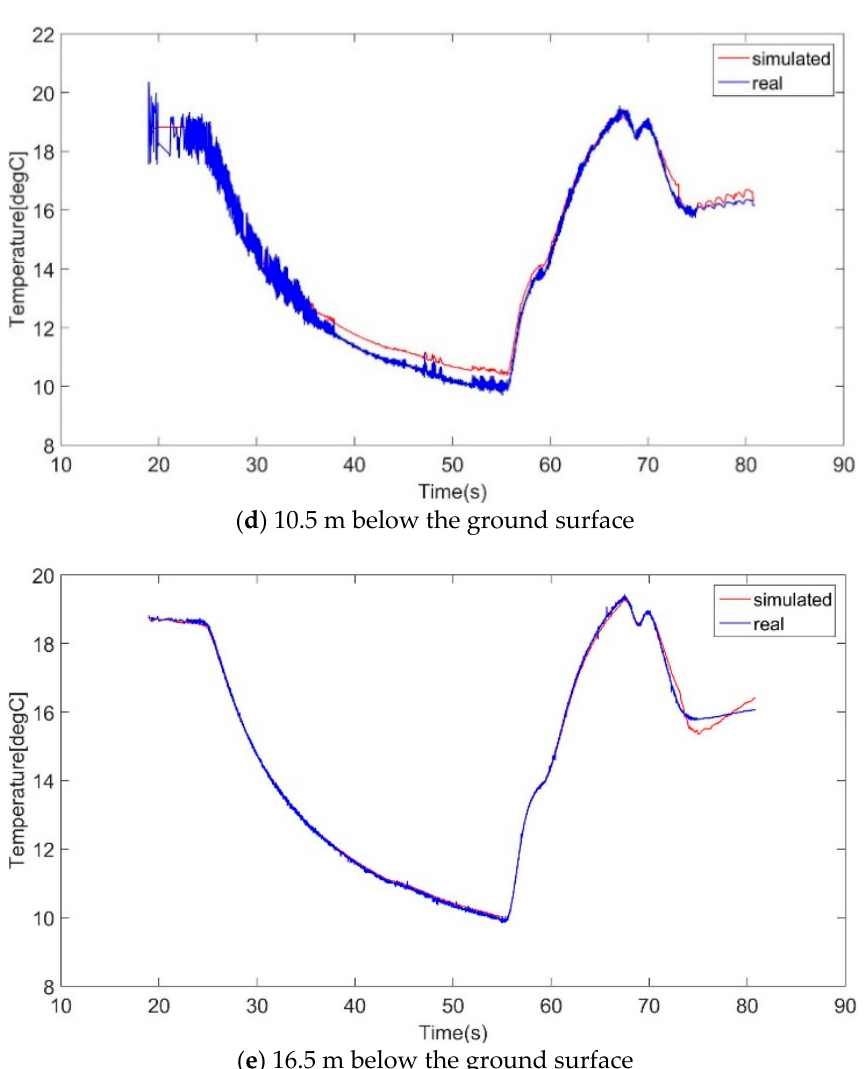
Figure 11. Temperature profiles in the borehole when the heat transfer coefficient across the concrete–soil surface was 5 W/m 2 K.